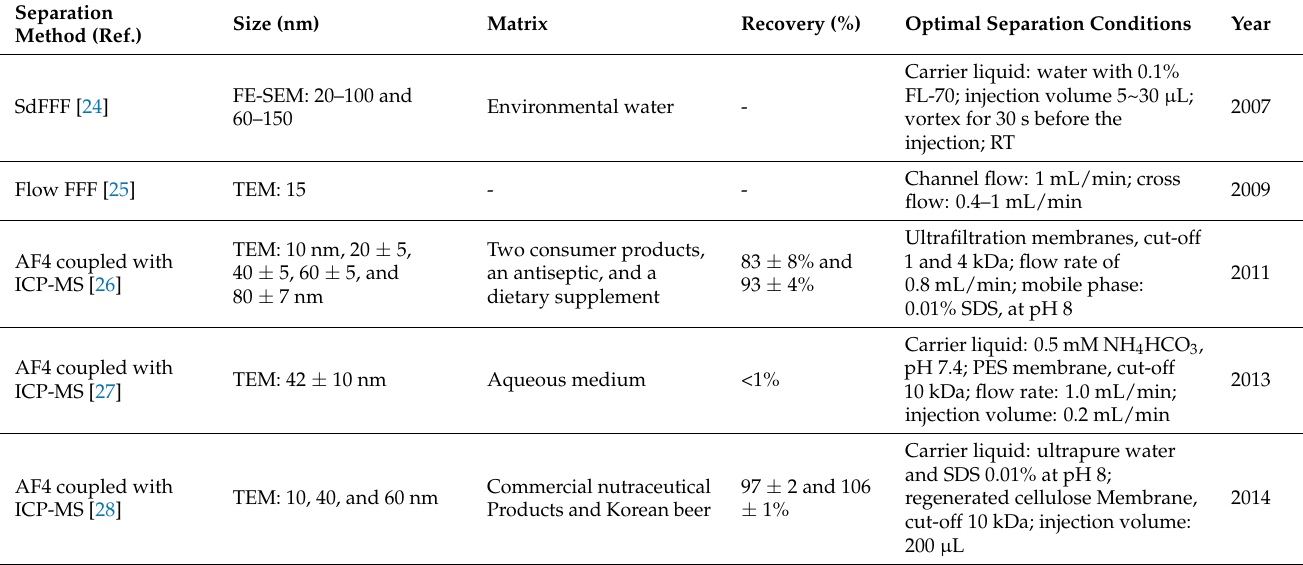
Table 2. Overview of AgNPs separation based on hydrodynamic